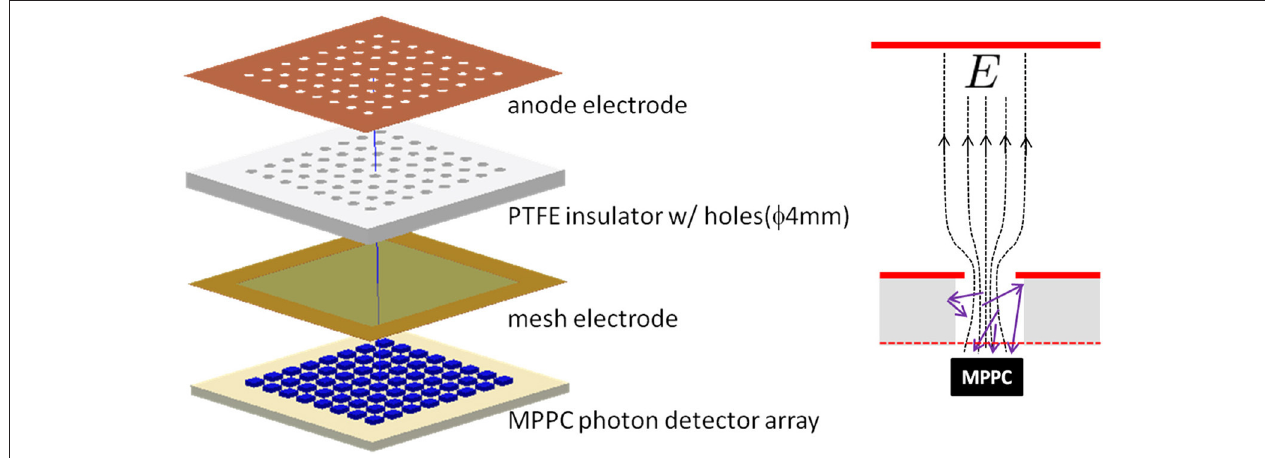
FIGURE 14 | The ELCC concept. Figure from Nakamura et al.